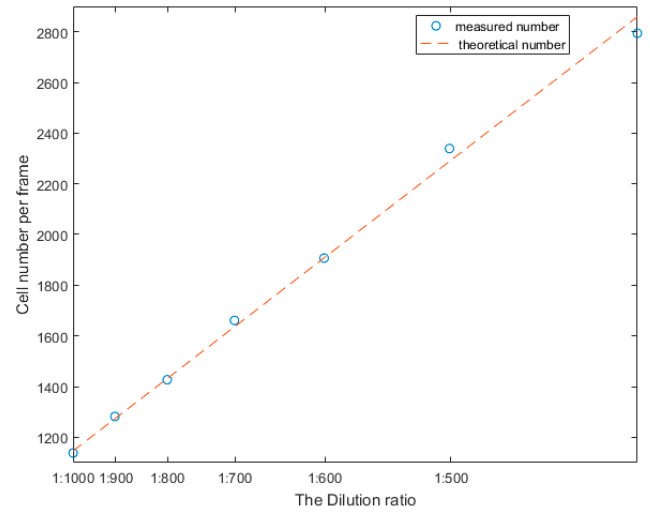
Figure 9. The result of linearity of different concentrations. Table 1. The result of different sample concentrations.